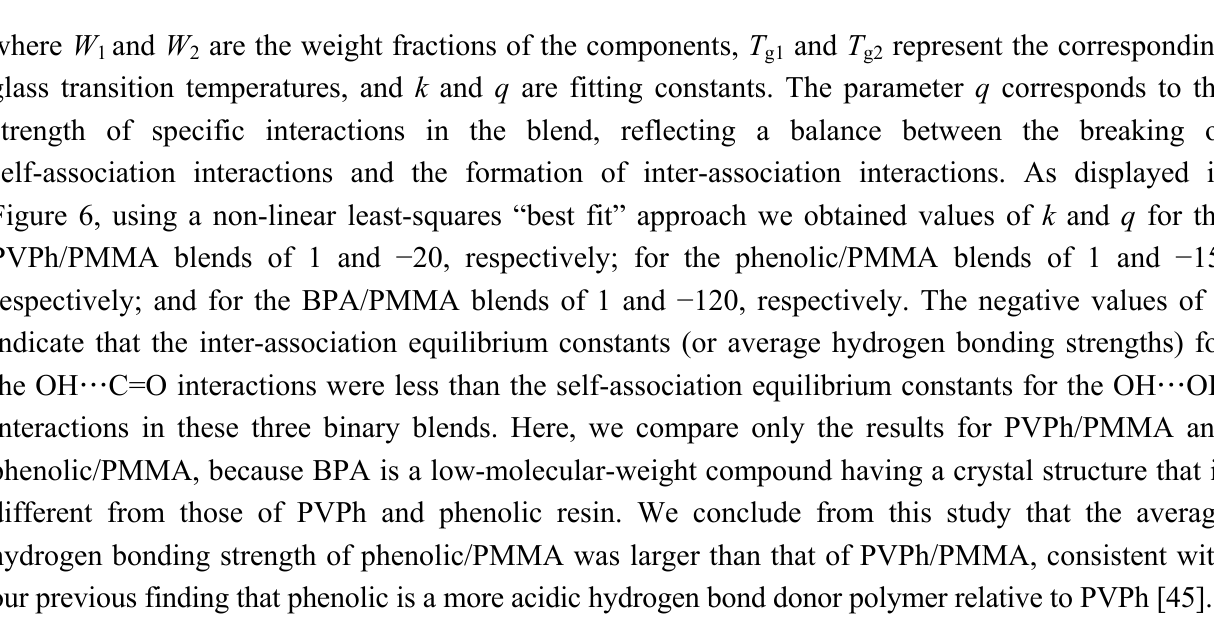
Figure 6. Glass transition temperature–composition curves, based on the Kwei equation, of PVPh/PMMA, phenolic/PMMA, and BPA/PMMA